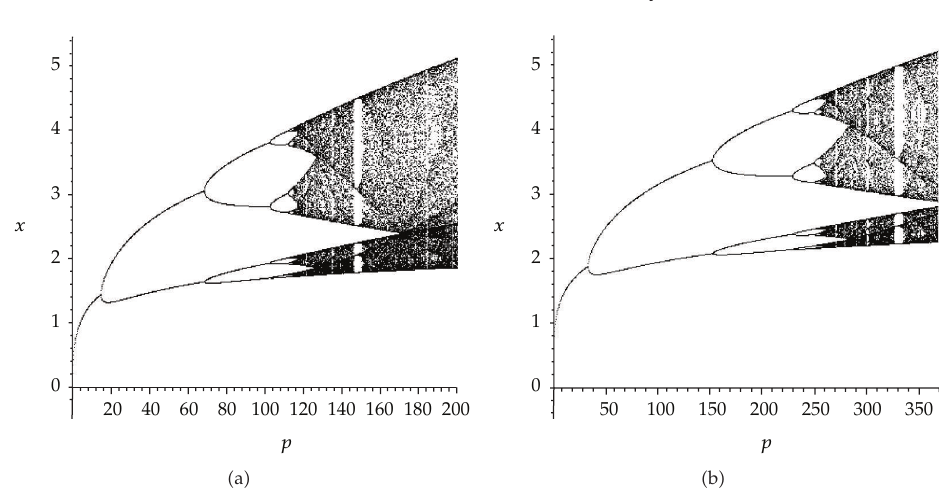
Figure 4: The bifurcation diagram for (cid:4) 2.1 (cid:5) , with α (cid:8) 0 . 5 , q (cid:8) 2, as p is growing (cid:4) a (cid:5) , and for the perturbed model (cid:4) 4.6 (cid:5) with α (cid:8) 0 . 5 , q (cid:8) 2 , and λ (cid:8) 0 . 2 (cid:4) b (cid:5) . For p < p c (cid:8) 0 . 75 e 3 ≈ 15 . 06 all trajectories of (cid:4) 2.1 (cid:5) converge to the equilibrium point x . As p increases beyond p c , there is a series of period-doubling bifurcations leading to a deterministic chaos. We see that the two bifurcation diagrams are similar, with bifurcations for larger p in (cid:4) 4.6 (cid:5) compared to (cid:4) 2.1 (cid:5) ; chaotic behavior is observed in the perturbed